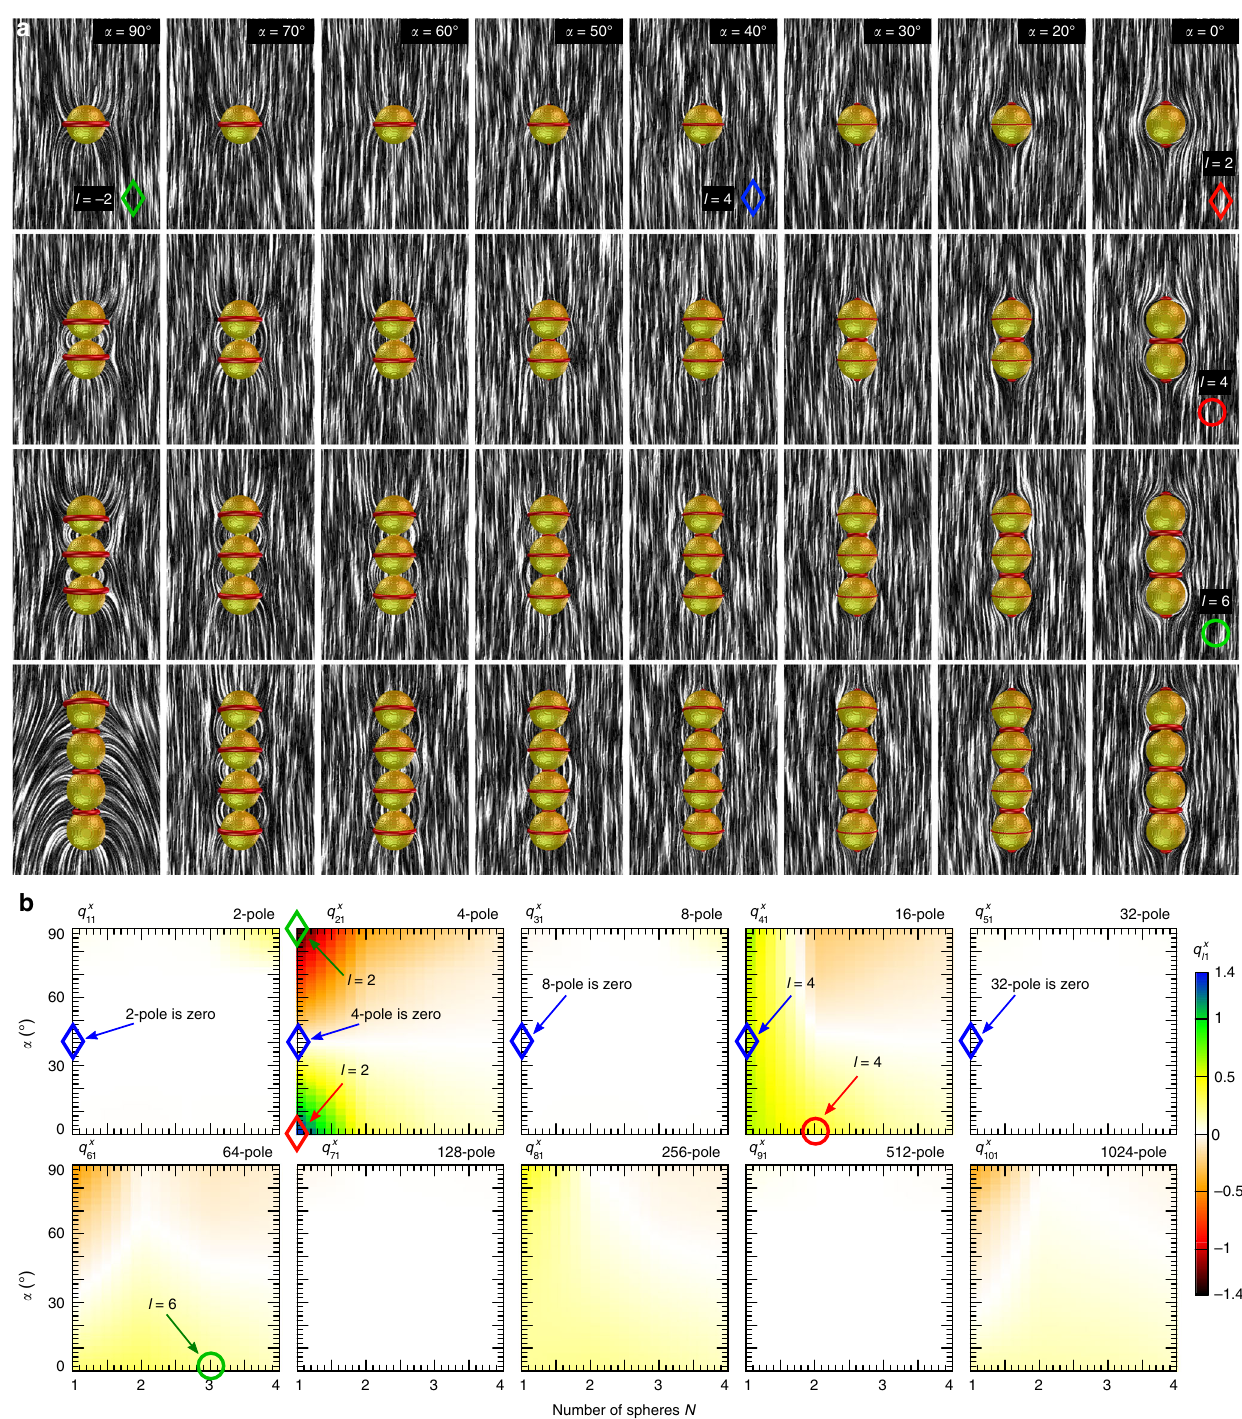
Fig. 8 Chain particles with conic anchoring and their elastic multipole moments. a The defects transitions from Saturn ring on the equator (homeotropic anchoring) to combination of both Saturn rings, neck defects and boojums (moderate angle α ) and ultimately to combination of neck defects and boojums (planar anchoring). The surface anchoring tilt angle notably affects n ( r )-distortions around the particle and consequently its multipole moment. b Chain composites have mirror symmetry along z -axis, therefore multipole moments with odd l are not present. a Circles show con fi gurations and b parameter space also realized in the experiments (see Fig. 7). Rhombs show a con fi gurations and b parameter space with pure multipoles. Strong quadrupole emerges for spheres with tangential or homeotropic anchoring on the surface (marked respectively by red and green rhombs). Sphere with conic anchoring angle α = 40° express dominant hexadecapole (marked by a blue rhomb) since the quadrupole and other multipoles are absent. The hexadecapolar moment is also dominant in particles comprising of two spheres with tangential anchoring (marked by a red circle). 64-Pole is weak, but for the particle comprising of three spheres it is the most prominent multipole (marked by a green